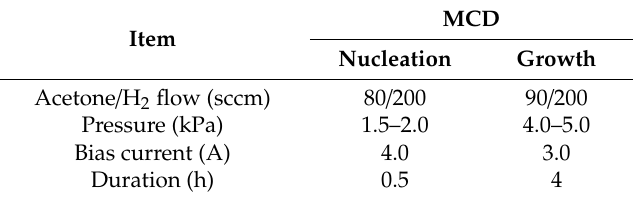
Table 1. Deposition parameters of the microcrystalline diamond (MCD)